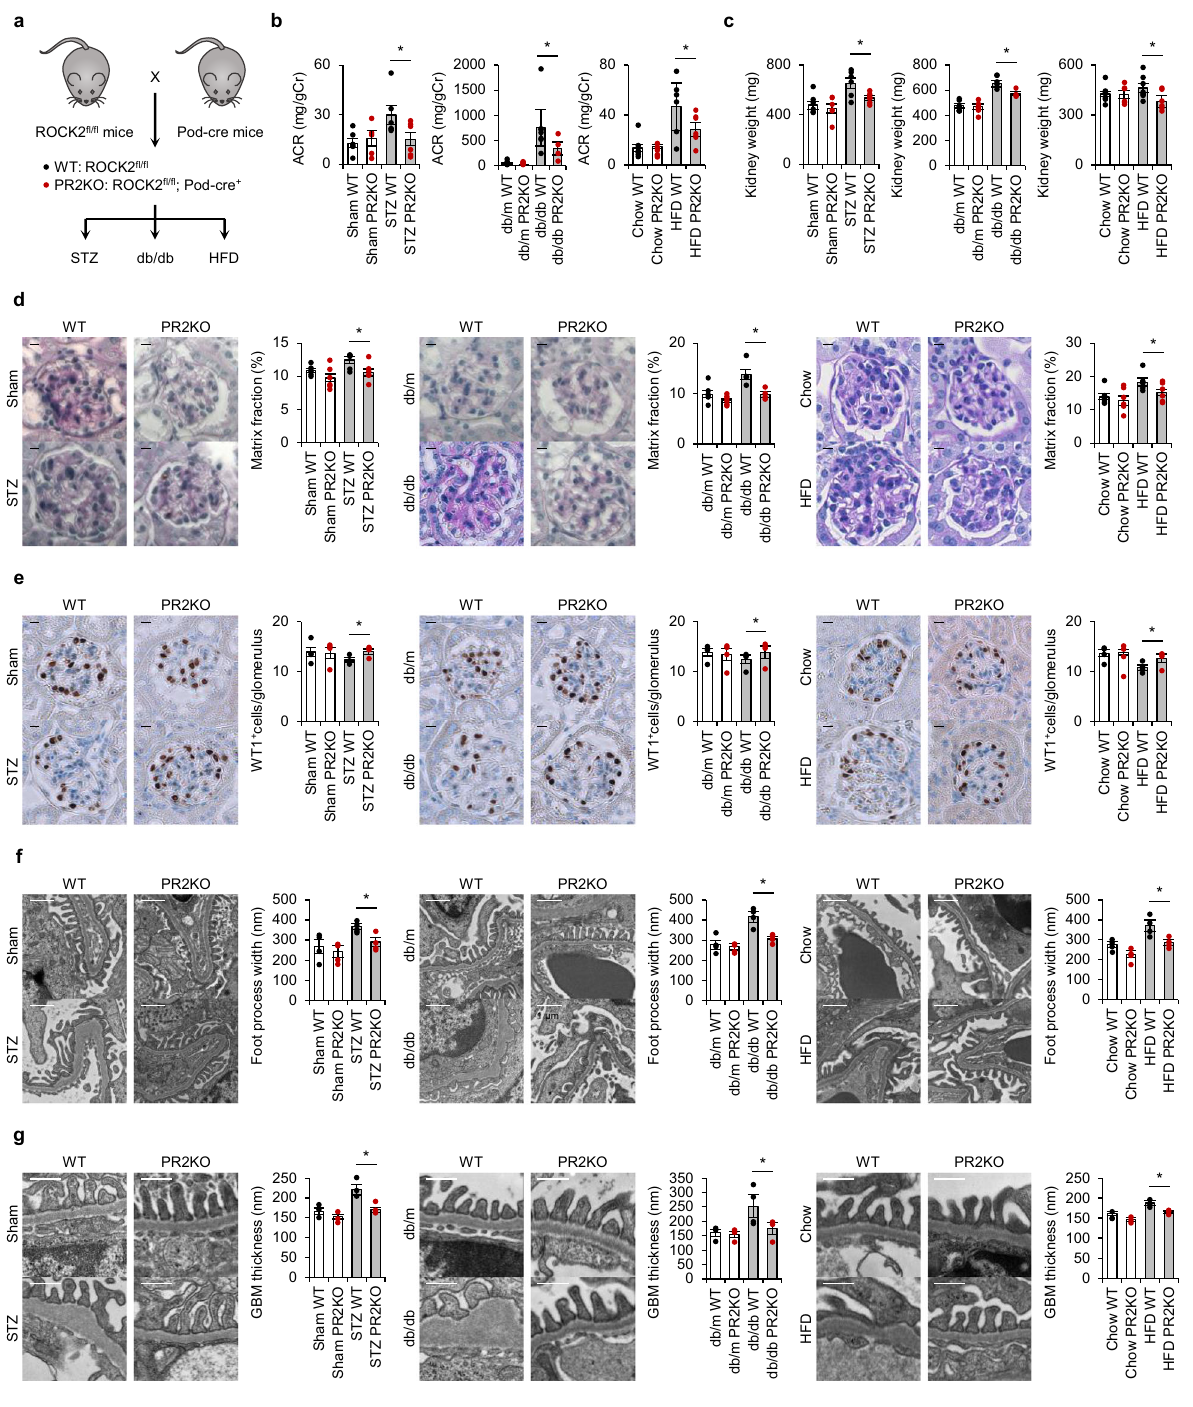
Fig. 3 Ablation of podocyte ROCK2 prevents diabetic renal damage in mice. a The breeding scheme that was used to generate PR2KO mice. Diabetes was induced by STZ injection, mating with db/m mice to generate db/db mice, or HFD feeding. b ACR in STZ-injected, db/db, HFD-fed WT and PR2KO mice ( n = 4 – 8). c The kidney weight in the three experimental groups ( n = 4 – 8). d Representative PAS-stained images of kidney glomeruli from mice. The scale bar on the top left represents 10 μ m ( n = 4 – 6). e Wilms tumor 1 (WT1) immunostaining and quanti fi cation of WT1-positive cells in glomeruli from mice. The scale bar on the top left represents 10 μ m ( n = 4). f Foot process width examined by transmission electron microscopy. The scale bar on the top left represents 1 μ m ( n = 4). g Glomerular basement membrane (GBM) thickness assessed by transmission electron microscopy. The scale bar on the top left represents 0.5 μ m ( n = 4). * p < 0.05. Data represent the mean ±